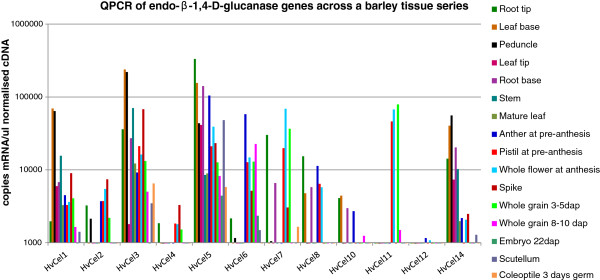
QPCR levels of 12 endo-(1,4)-β-glucanase genes across the developmental tissue series from barley. The vertical axis is a log10 scale and shows relative transcript levels of the genes normalised against three control genes. The vertical axis crosses the horizontal axis at 1000 copies mRNA per μl normalised cDNA. This is an arbitrary level, below which transcript levels are considered to be unreliable.